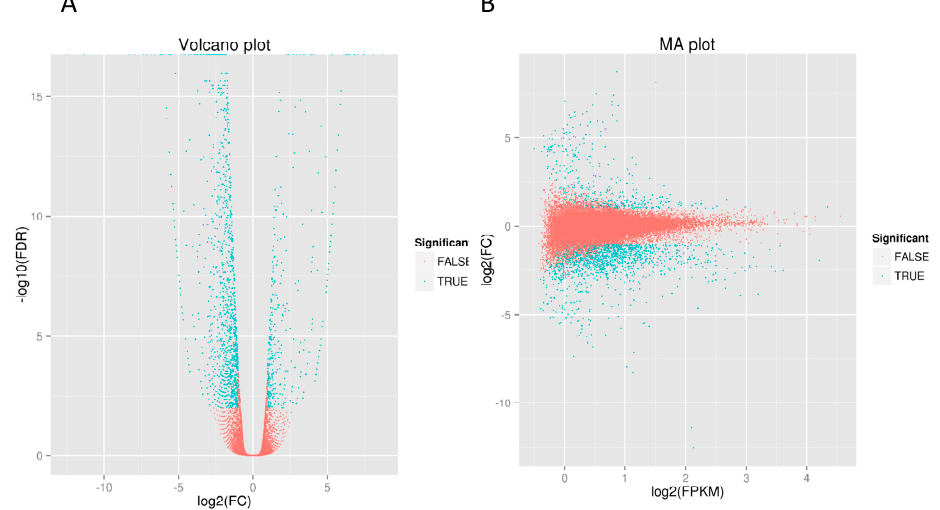
Figure 4. Analysis of differentially expressed genes in YL and GY skin color of A. davidianus . ( A ) Volcano plot; the x -axis represents the logarithm value of the multiple difference of expression amount of a certain gene in two samples. The larger the absolute value, the larger the multiple difference of expression amount between two samples. The y -axis represents the negative pair value of the error discovery rate. The larger the value, the more significant the differential expression. ( B ) MA plot; the horizontal coordinate is the value A: log 2 (FPKM), which is the logarithm value of the mean values of the two samples. The ordinate is the M value: log 2 (FC), that is, the logarithmic value of the multiple difference of gene expression between two samples. Each point in the volcano plot map represents a gene, and the y -axis represents the logarithm of the multiple difference of expression amount of a certain gene in two samples. The green dots represent genes with significant expression differences and the red dots represent genes with no significant expression differences. Additionally, for annotation and validation, all DEGs were subjected to analysis using seven public databases, including COG, GO, KEGG, Pfam, Swiss-Prot, KOG, and NR, and a total of 1252 DEGs were annotated (Table S6). GO analysis showed that there was a significant difference between DEGs and other unigenes in receptor regulatory activity, cell aggregation, and hormone secretion, suggesting that the variation may be attributed to a skin-specific function of A. davidianus (Figure 3) . DEGs in the COG analysis were concentrated in cytoskeleton, signal transduction mechanisms and replication, recombination, and repair (Figure 5). In the KEGG enrichment analysis, most DEGs were classified into the following pathways: focal adhesion, ECM–receptor interaction, and tight junction (Figure 6 and Table 2).